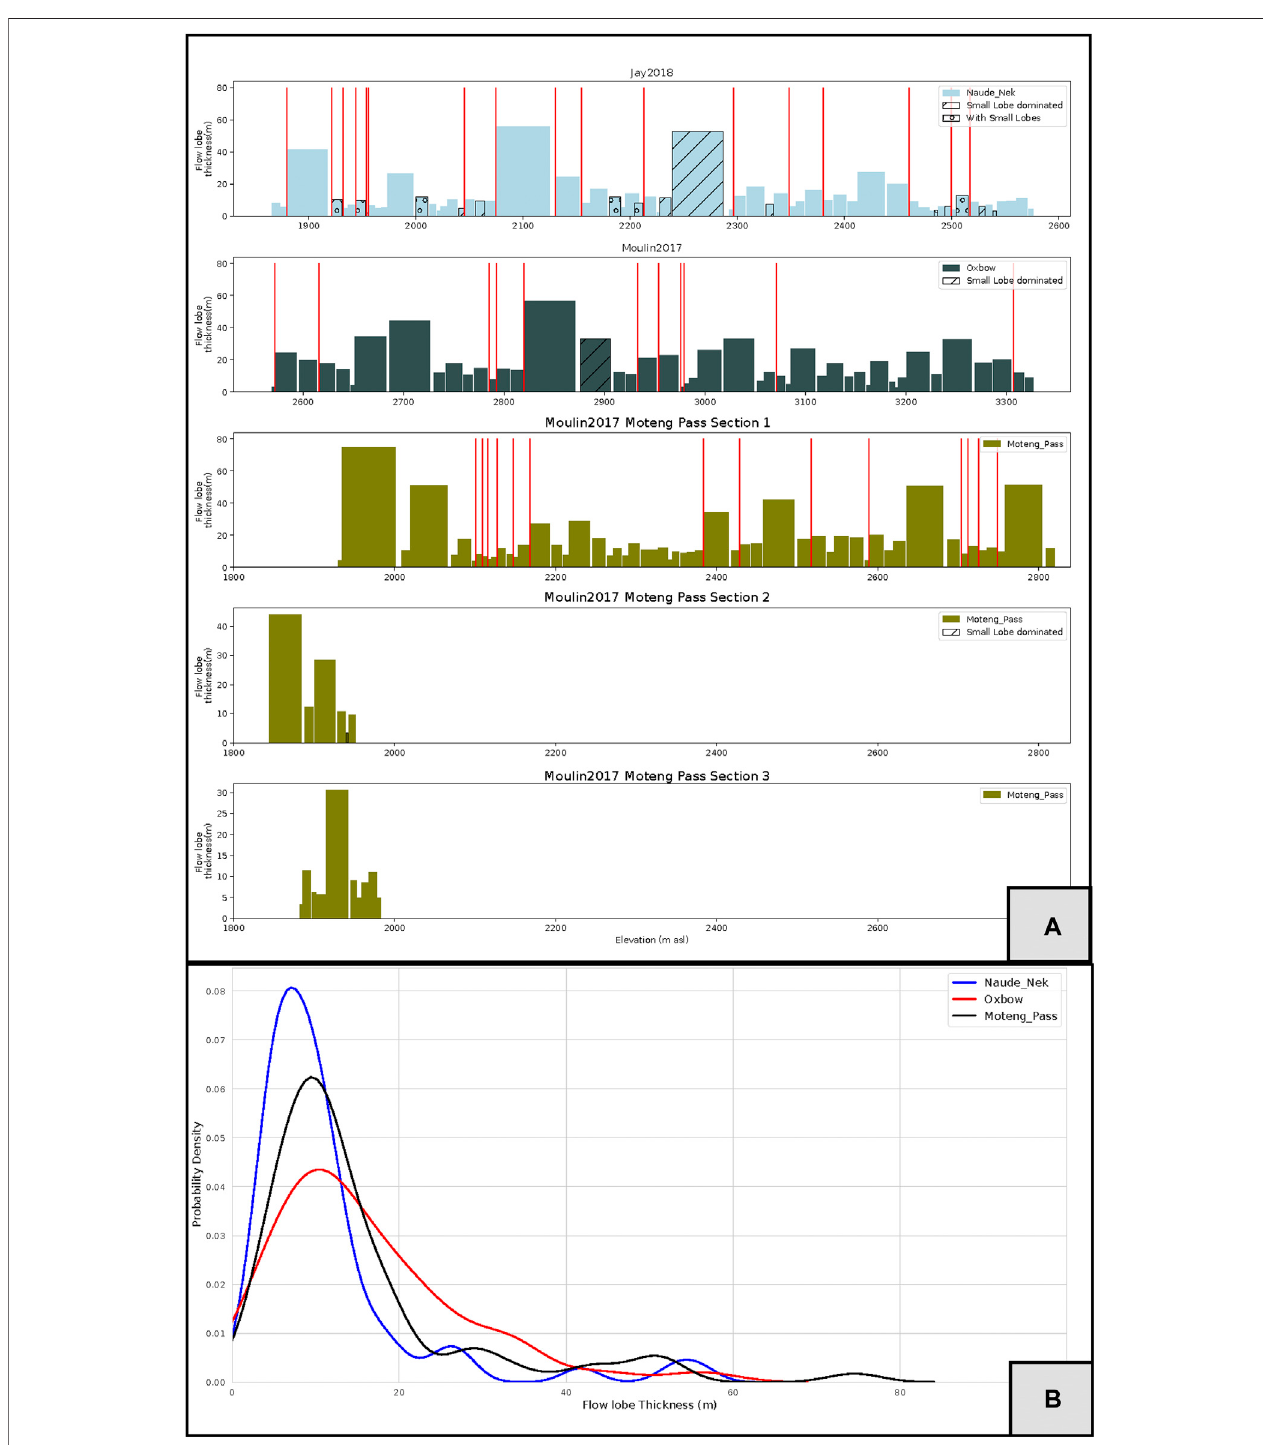
FIGURE 7 | (A) Plots of lobe thickness for Lesotho part of Karoo CFB Province from Jay et al. (2018) and Moulin et al. (2017) plotted as function of altitude above mean sea level; width of bar (cid:1) lobe thickness. Groups shown by bar color (see key in B ); + open dots (cid:1) with small lobes; + stars (cid:1) small-lobe-dominated. Red vertical lines (cid:1) boles (weathering horizons, note bole line thickness not to scale). (B) Plots of univariate kernel density estimators to calculate PDFs of lava lobe thicknesses of three Karoo sequences. Note relative similarity of the three distributions, due to SLs from 15 to 18 m thick, with Naude Nek lobes being a little thinner due to prevalence of HP lobes down to a few meters thickness.